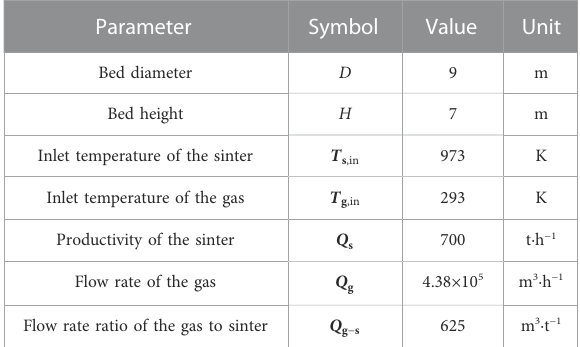
TABLE 1 Structural and operating parameters of the sinter vertical cooling